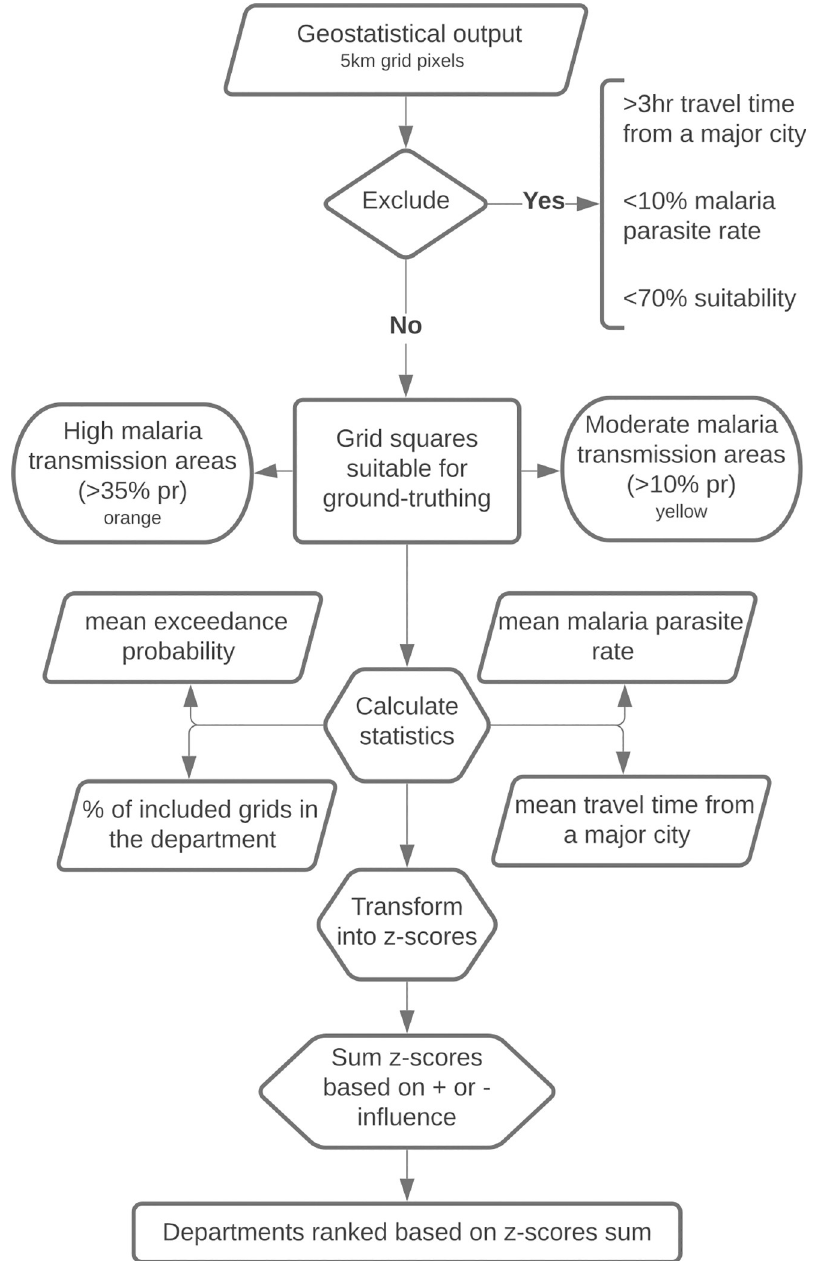
Fig 2. Flow chart to select the grid squares for the ground-truthing and to rank departments into ground- truthing/implementation priority.